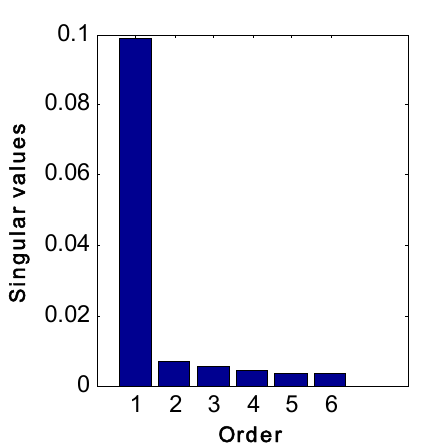
Figure 1. Singular values of the matrix Z , Equation (3), resulting from input/output data collected for a 2 × 2 distillation column excited by pseudo random binary sequence (PRBS) inputs.